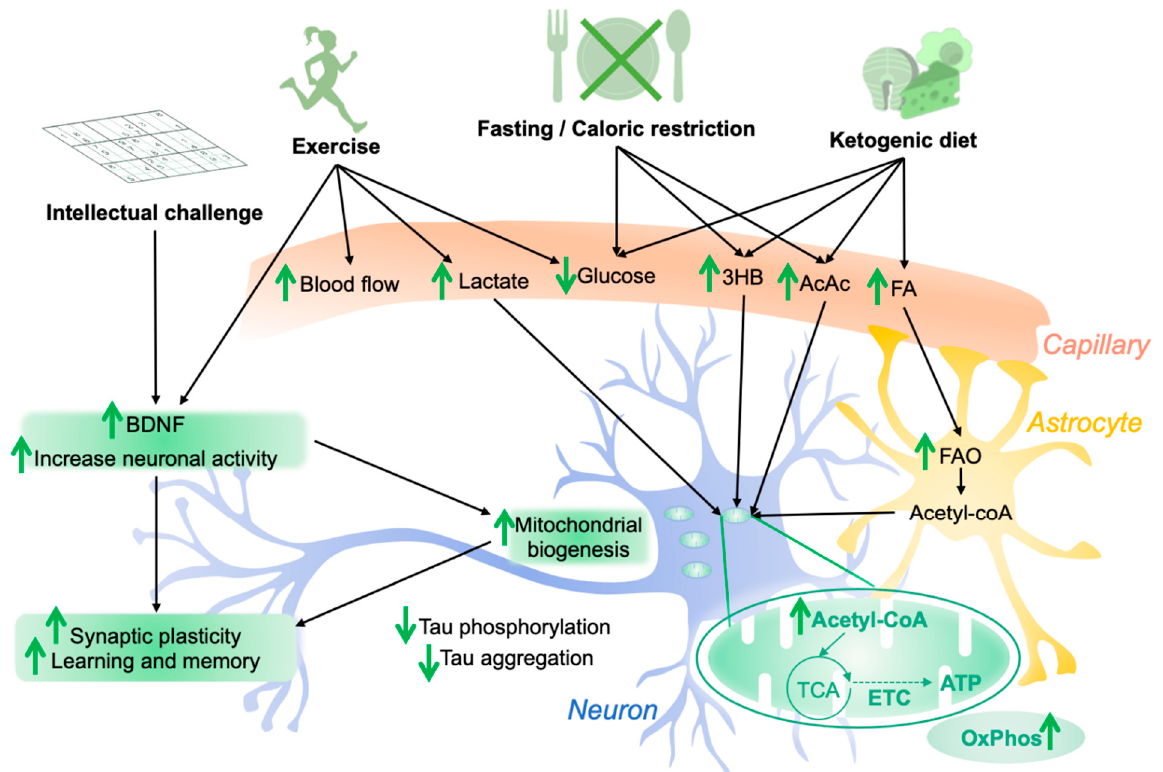
Figure 3. Influence of lifestyle factors on brain bioenergetics and tau pathology. Modified diet (e.g., fasting, caloric restriction, ketogenic diet) results in changes in brain levels of glucose, ketone bodies (3HB, AcAc) and fatty acids (FA), which are transported via the blood flow. FA can be metabolized by fatty acid oxidation (FAO) in astrocytes, providing energy substrates to neurons under the form of acetyl-coA. Ketone bodies can directly be used by neurons to fuel the tricyclic acid cycle (TCA) and oxidative phosphorylation (OxPhos), increasing mitochondrial bioenergetics and neuronal health. Physical exercise is known to improve brain function by increasing brain-derived neurotrophic factor (BDNF) levels, synaptic plasticity, mitochondrial biogenesis, and neurogenesis, improving cognitive functions such as learning and memory. Moreover, exercise is accompanied with an increase in lactate production by muscles. Lactate can be used by neurons as a bioenergetic substrate for OxPhos. Intellectual challenges were shown to increase neuronal network activity, increasing synaptic plasticity and cognitive function. These lifestyle factors were shown to decrease tau pathology, at least in in vivo animal models, but the underlying mechanisms, as well as their influence on tau pathology in humans, remain to be clearly identified. Abbreviations: 3HB, 3- β -hydroxybutyrate; AcAc, acetoacetate; ATP, adenosine triphosphate; ETC, electron transport chain; green arrows: ↑ increase/ ↓ decrease.